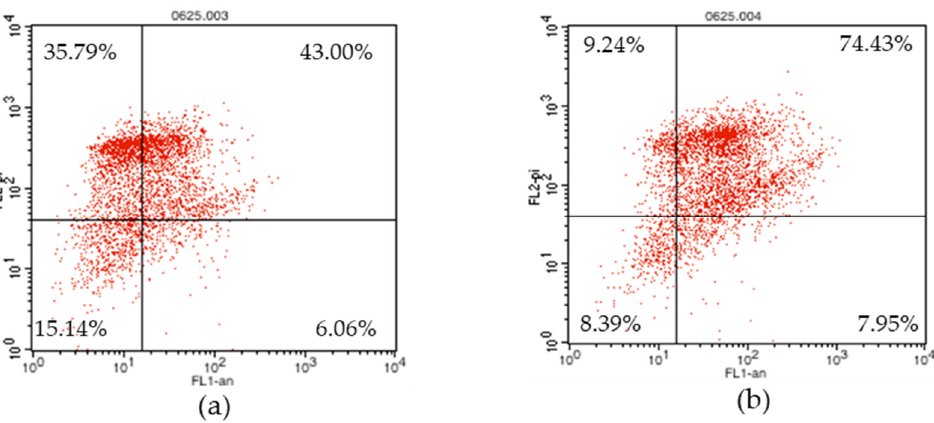
Molecules 2021 , 26 , x FOR PEER REVIEW Figure 6. Flow cytometry analysis of apoptosis via annexin V/PI dual staining in the RWPE-1 cell. ( a ) Flow cytometry analysis of apoptosis treated with compound 1 . ( b ) Flow cytometry analysis of apoptosis treated with compound 2 .